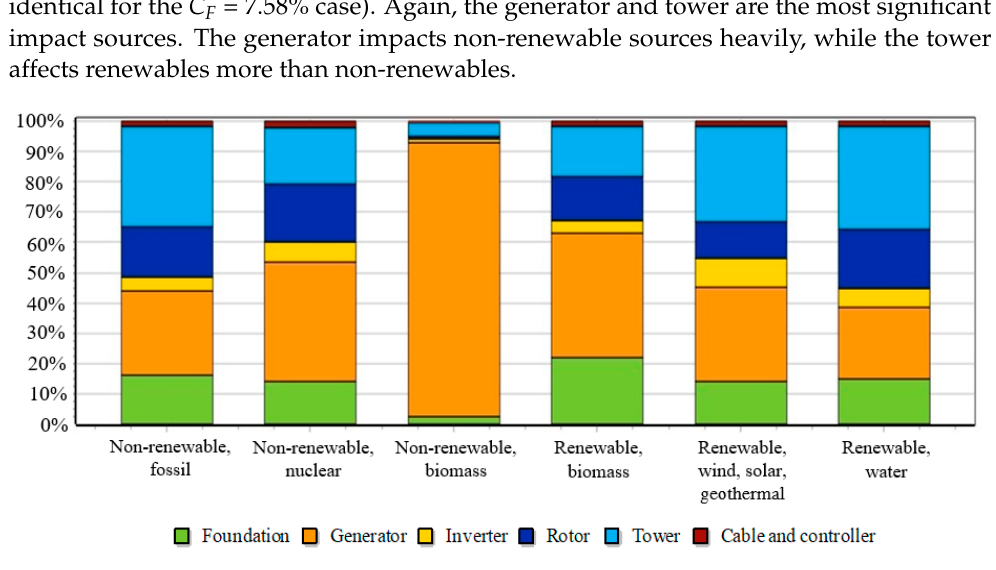
Figure 6. Cumulative energy demand (CED) for renewables and non-renewables per component.